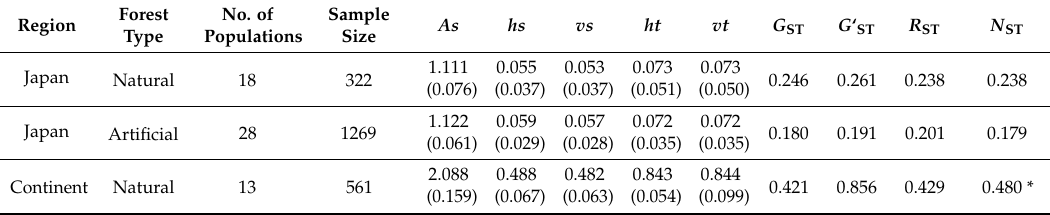
Table 3. Genetic diversity and genetic differentiation in the three population groups of Quercus acutissima Carruth.: Natural and artificial populations in Japan plus natural continental populations. Forest Region Type